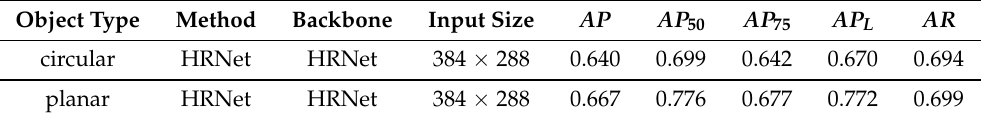
Table 1. The results of keypoints detection.